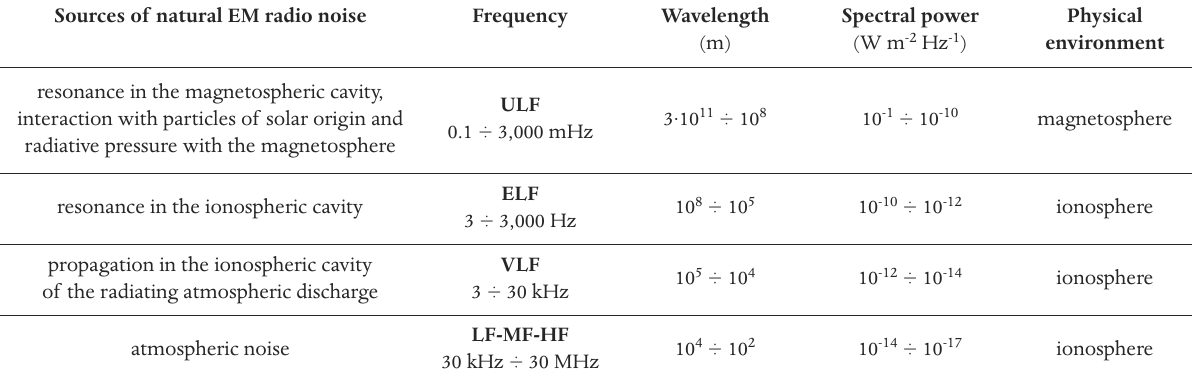
Table 1. Main physical characteristics of the natural EM radio noise sources in the magnetosphere and